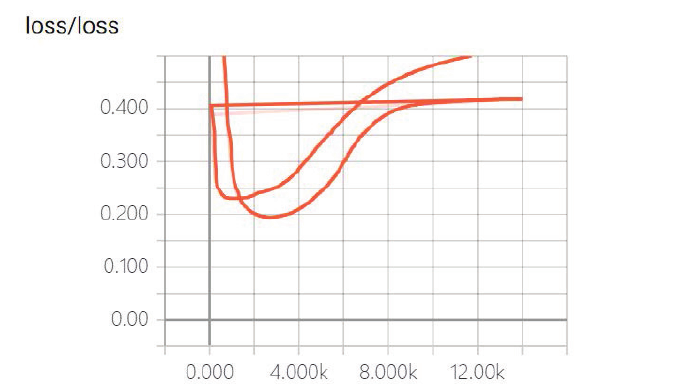
Figure 5. Different feature sets comparison result on